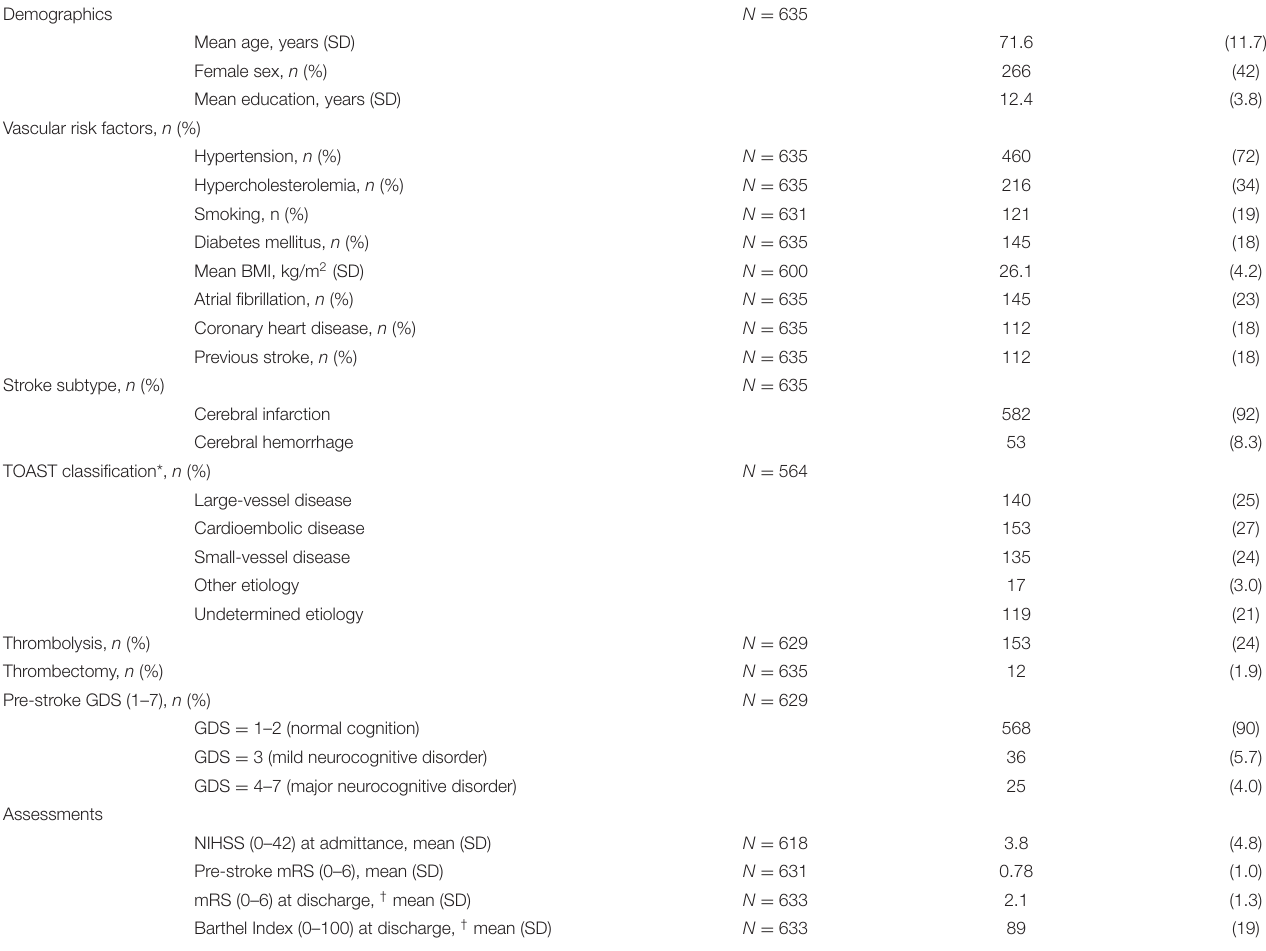
TABLE 1 | Baseline characteristics.